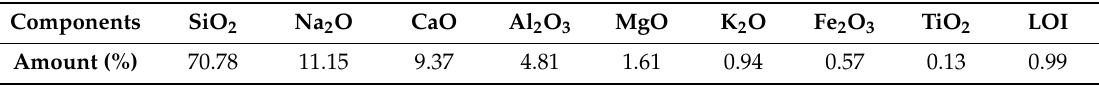
Ceramic, stone, and porcelain (CSP) chemical characterization by means of X-ray fluorescence (XRF).